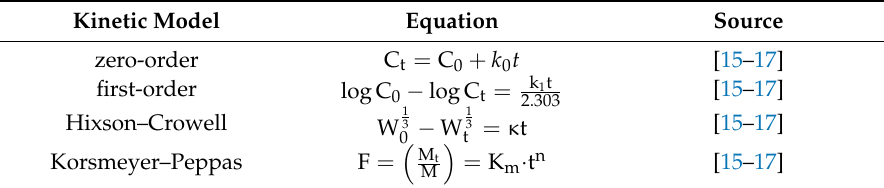
Table 1. Selected kinetic models applied for the evaluation of release kinetics.